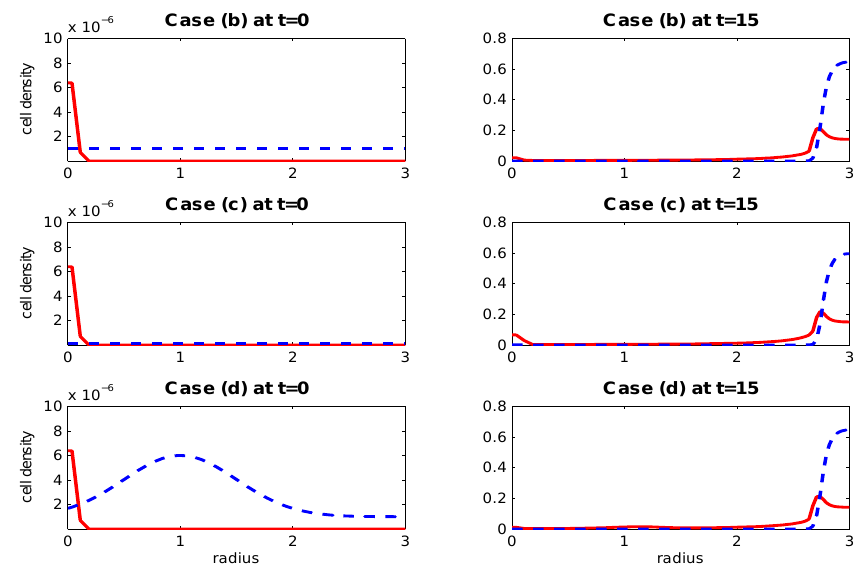
Figure 2. Numerical solutions to (2.1)–(2.2) at t = 15 days (right-hand side pictures) and their initial values at t = 0 (left-hand side pictures). Proliferating cells are denoted by solid lines and migrating cells by dashed